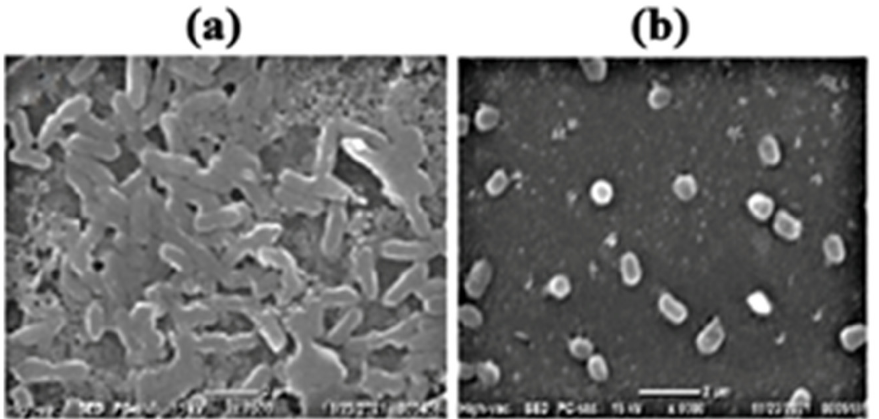
Figure 2. Representative scanning electron micrographs showing biofilm disruption on glass surfaces: ( a ) biofilm formed by Aeromonas sp.; ( b ) biofilm disruption by co-incubation with 100 µL of CFS form Klebsiella pneumoniae and bacterial culture of Aeromonas sp.